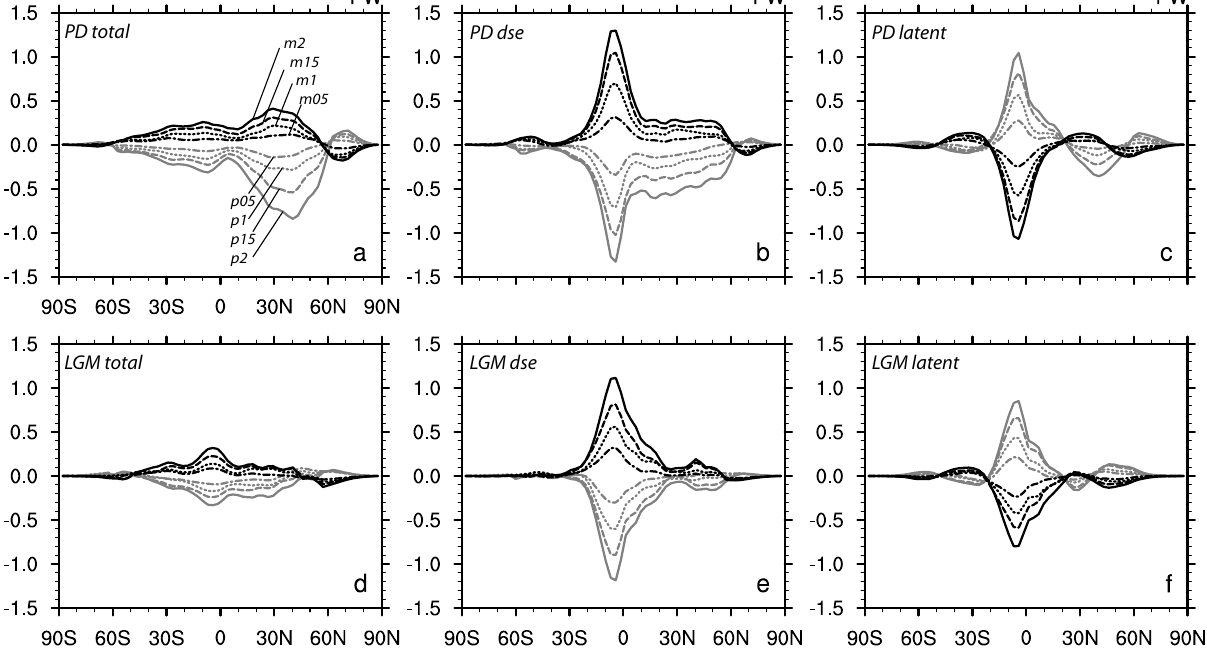
Fig. 3. Atmospheric transport anomalies: total – (a) and (d) , DSE – (b) and (e) , latent heat – (c) and (f) – for PD (upper plots) and LGM (lower plots) simulations. Black curves: NH cooling simulations ( m2 , m1.5 , m1 and m0.5 ), grey curves: NH warming simulations ( p2 , p1.5 , p1 and p0.5